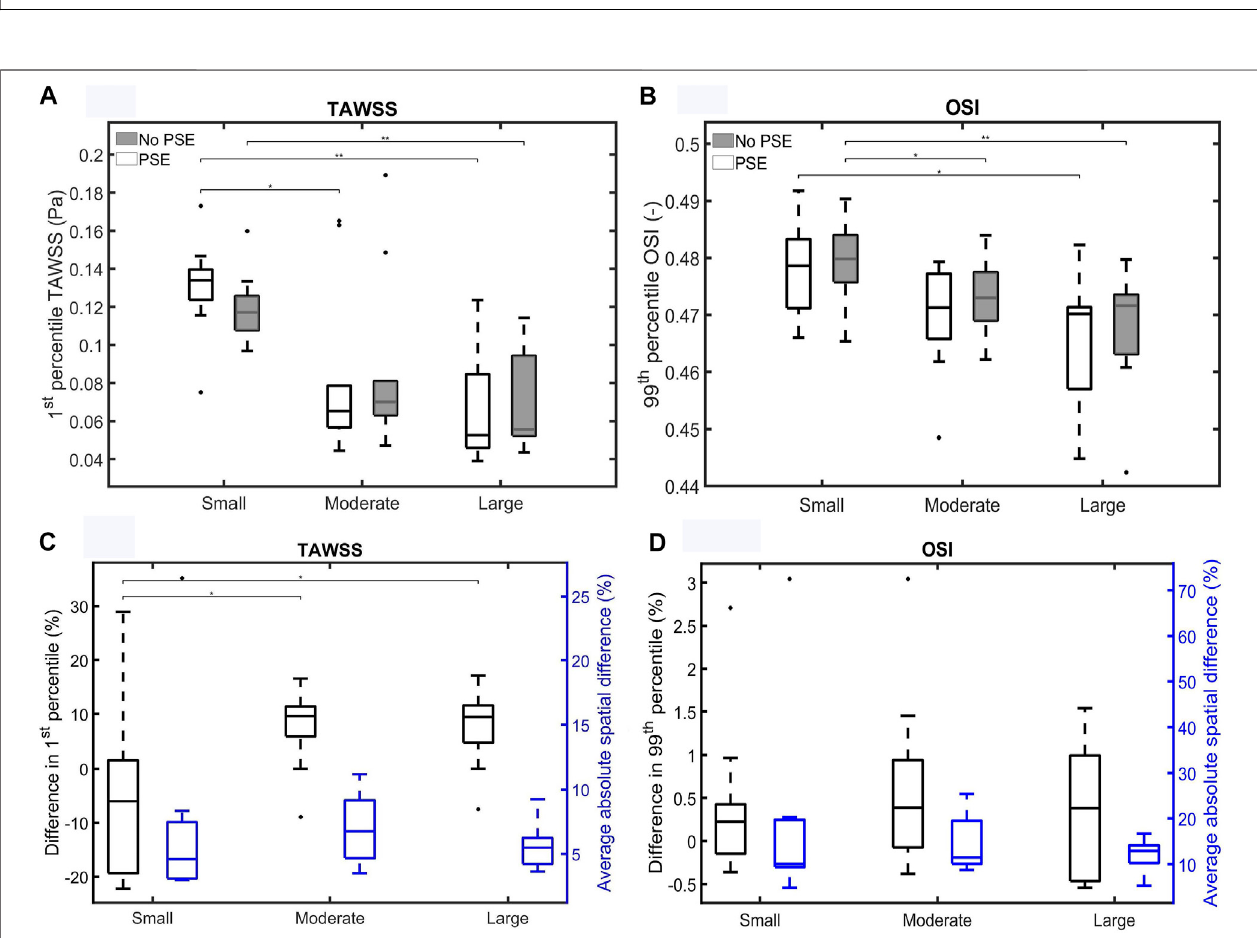
absolute spatial difference equals 14.7%, as shown in Figure 11D . No signi fi cant differences in average absolute spatial differences between groups were found for the OSI.